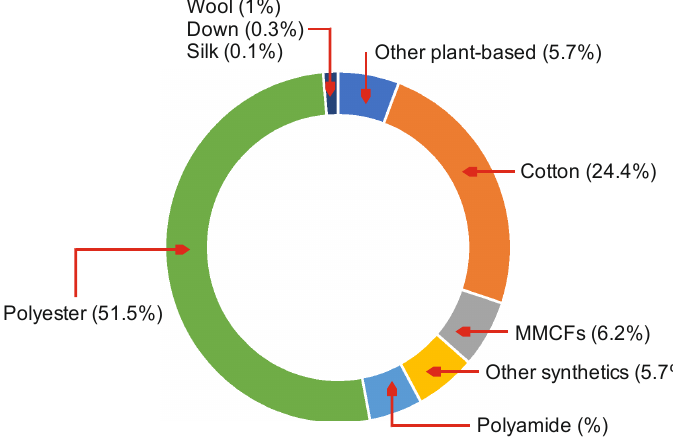
Figure 2. Fiber-type market share [5].